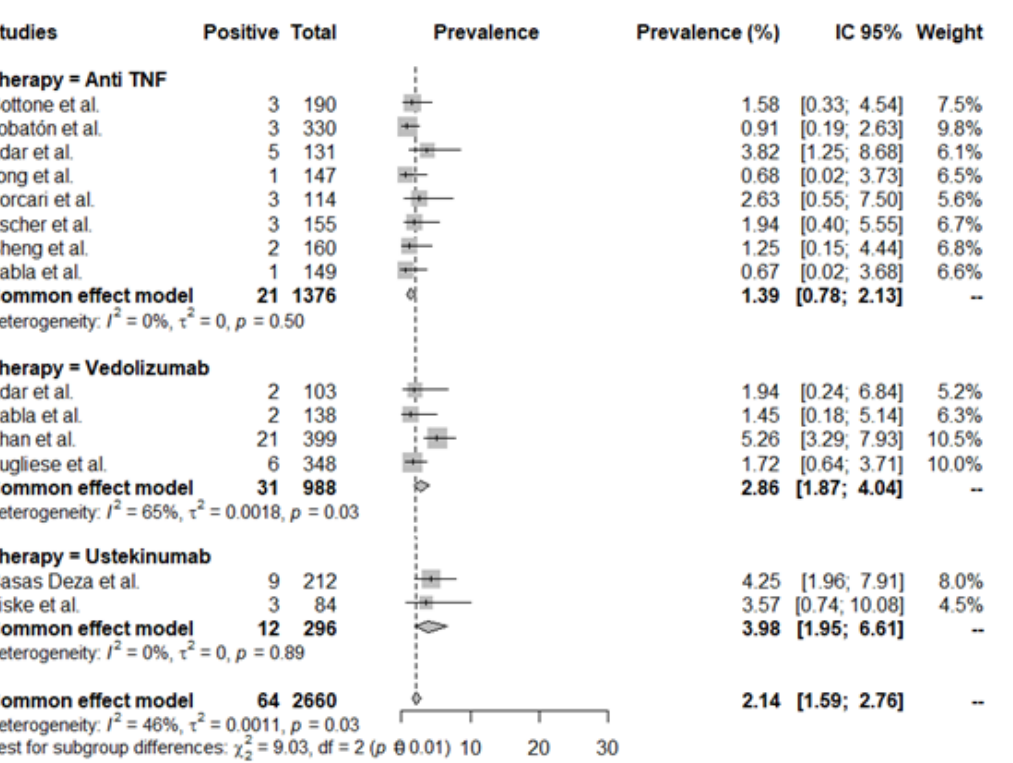
Figure 5. Malignancy rates. Mean rates per 100 patient years (PY).